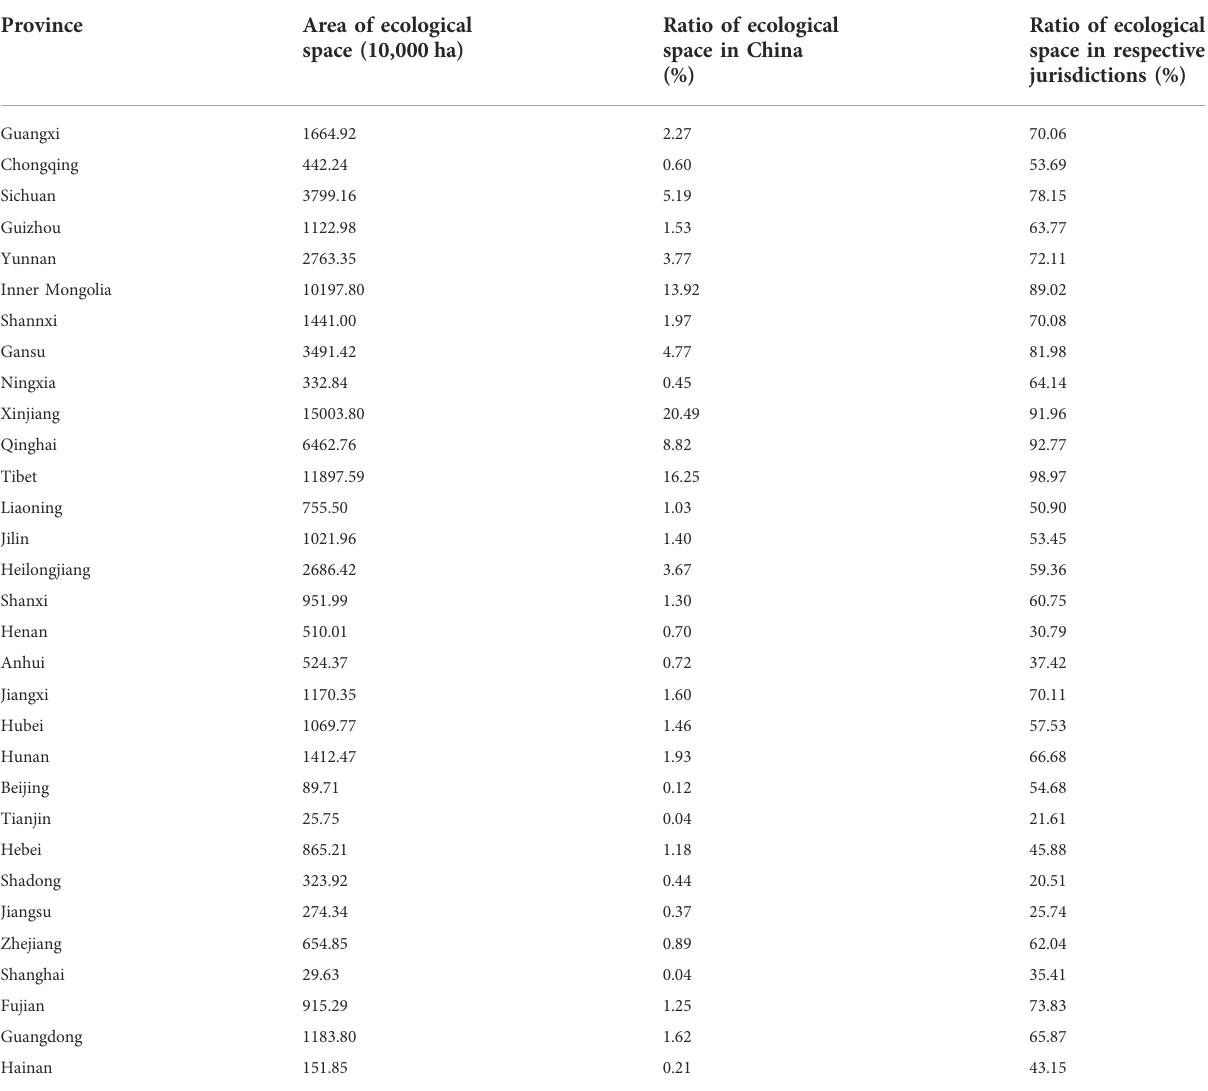
TABLE 4 Area and ratio of ecological space in